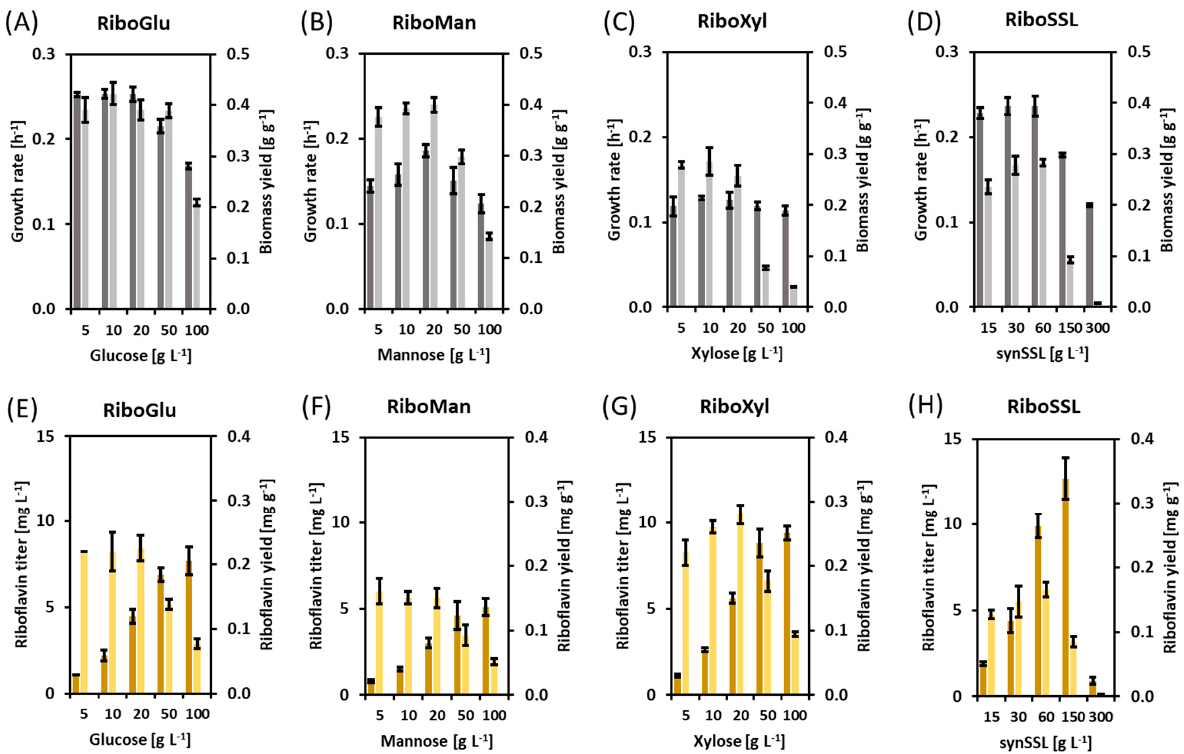
Figure 1. ( A ) Growth values of the strain RiboGlu. ( B ) Growth values of the strain RiboMan. ( C ) Growth values of the strain RiboXyl. ( D ) Growth values of the strain RiboSSL. ( E ) Production values of the strain RiboGlu. ( F ) Production values of the strain RiboMan. ( G ) Production values of the strain RiboXyl. ( H ) Production values of the strain RiboSSL. Upper plots depict growth rates [h − 1 ] (dark grey bars), and biomass yields (g g − 1 ) (light grey bars). Lower plots depict riboflavin titers [mg L − 1 ] (dark yellow bars), and riboflavin yields (mg g − 1 ) (light yellow bars). Values represent means and standard deviations.